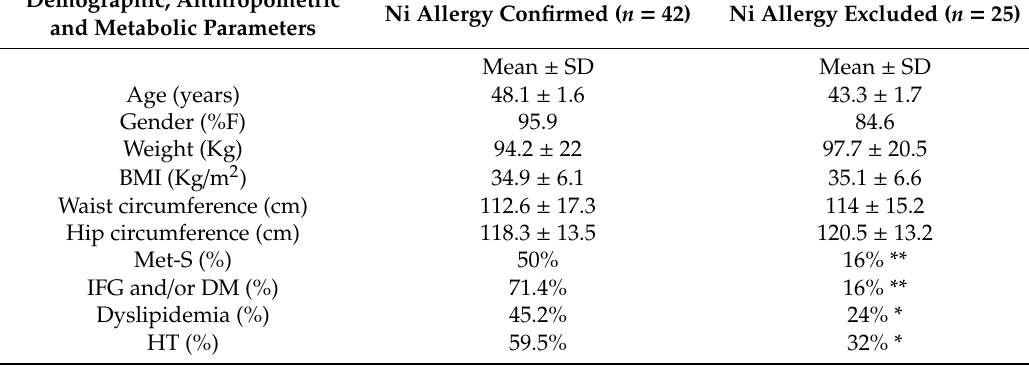
Table 1. General and metabolic di ff erences between patients testing positive or negative to a Ni patch test are shown. Abbreviations: SD, Standard Deviation; Ni, Nickel; BMI, body mass index; Met-S, Metabolic Syndrome; IFG, impaired fasting glucose; DM, diabetes mellitus; HT, hypertension. * p <